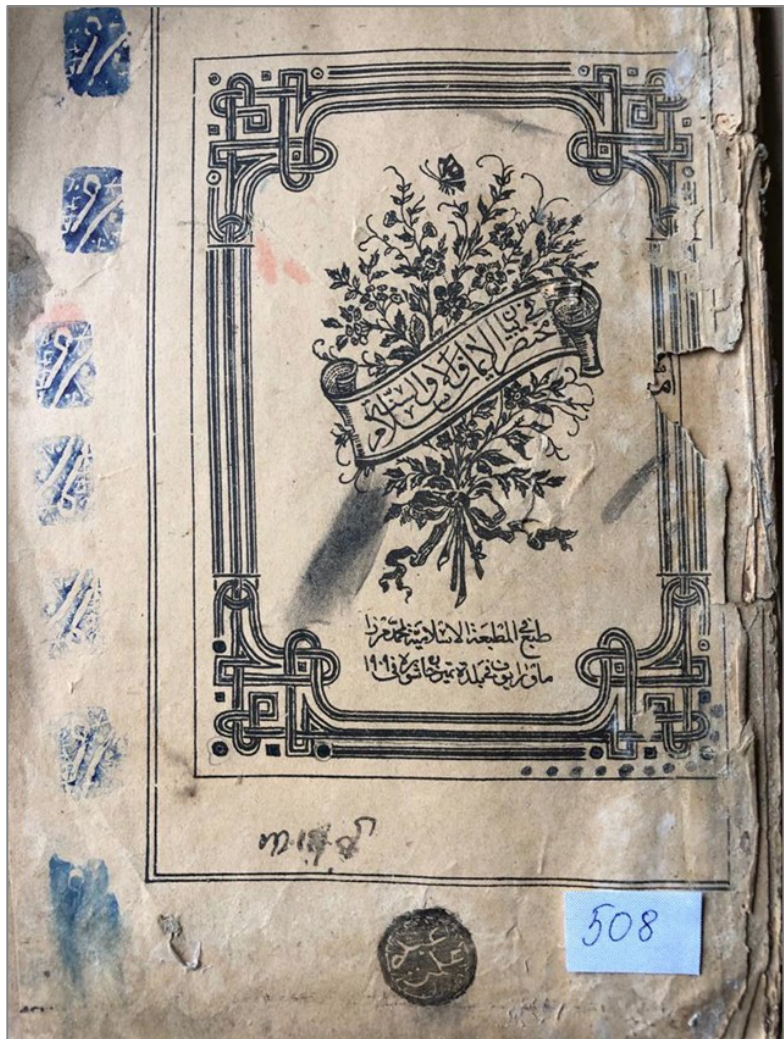
Figure 2 - The 3 rd edition of “Muhtasar fi Bayan al-Iman va-l-Islam va-s-Sunnah” DOI: https://doi.org/10.18454/RULB.2022.33.2.2